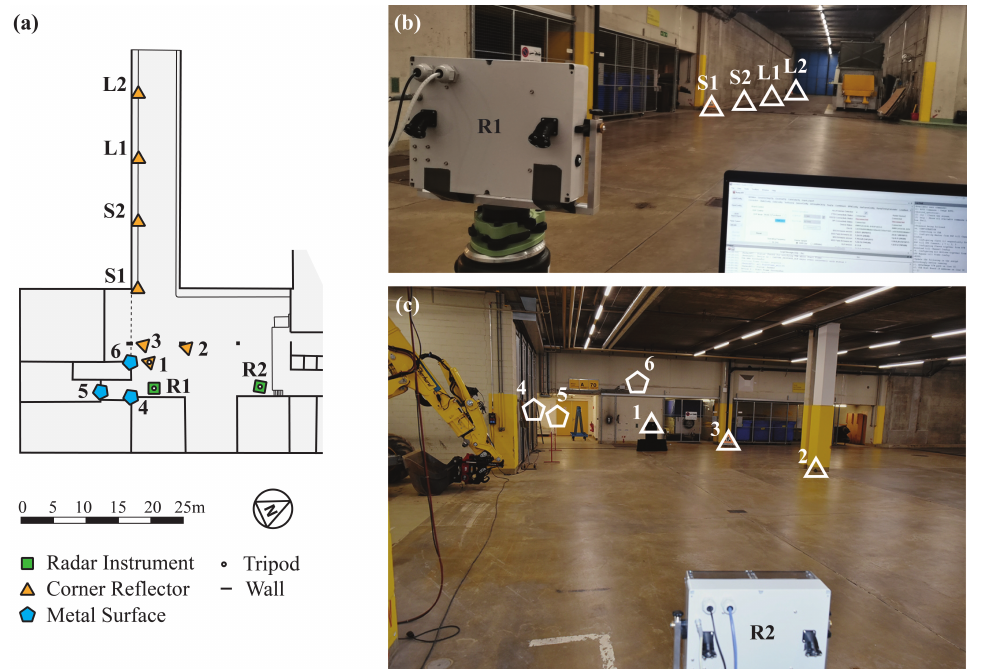
Figure 7. ( a ) Floor map of the measurement setups highlighting the positions of the radar instrument (square), the corner cubes (triangle), and other targets (pentagon). ( b ) Measurement setups for the static indoor experiment. ( c ) Measurement setup for the dynamic indoor experiment.